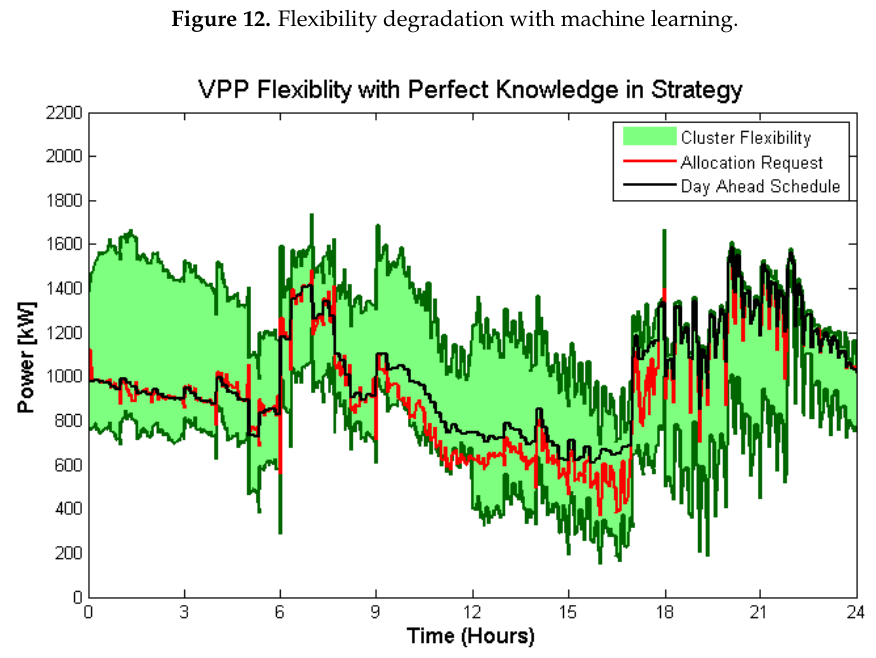
Figure 13. Flexibility degradation with perfect